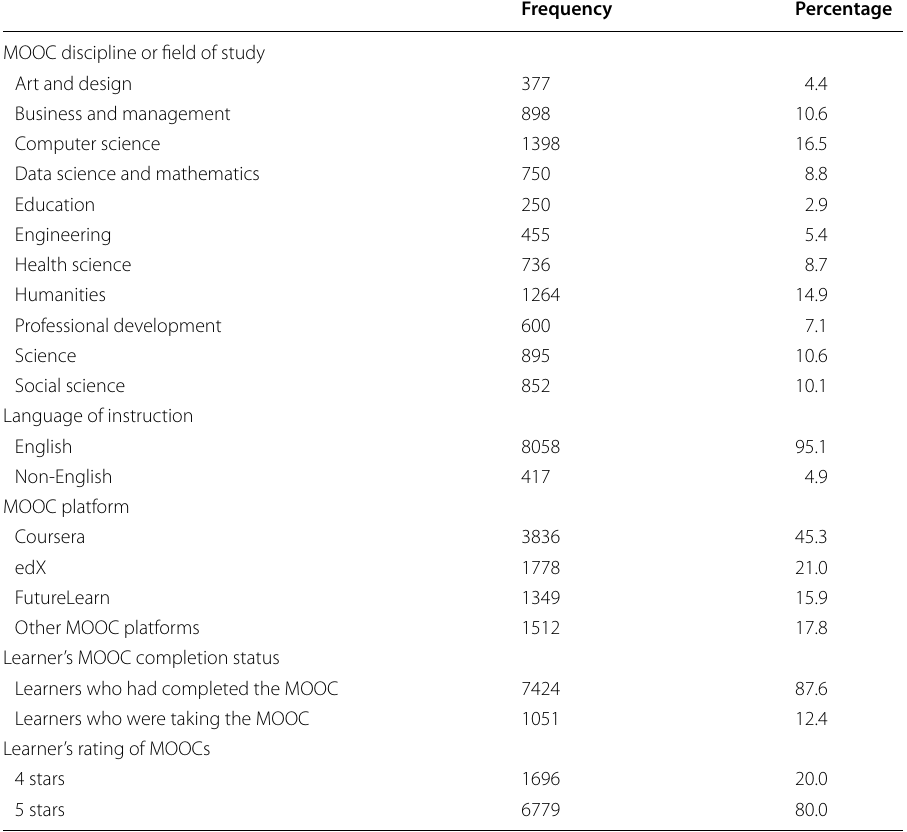
Table 2 Information about the selected